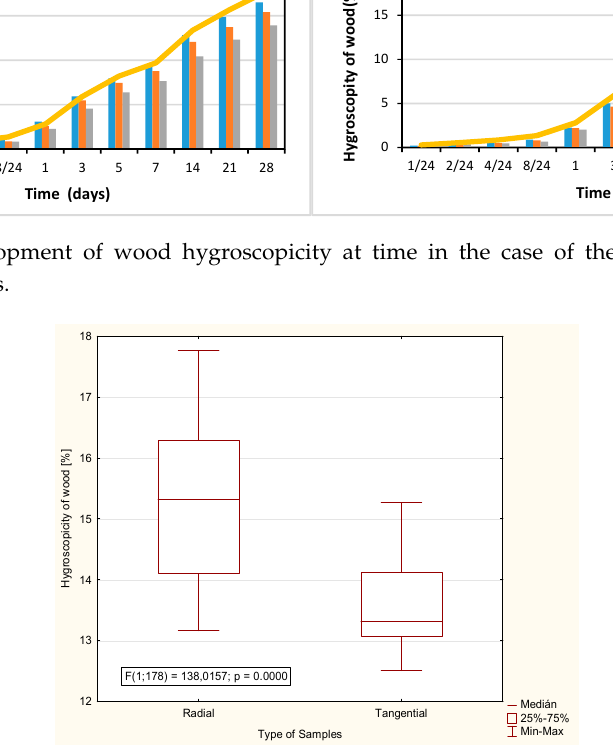
Figure 10. Impact type of sample on the values of wood hygroscopicity ( p < 0.0000).